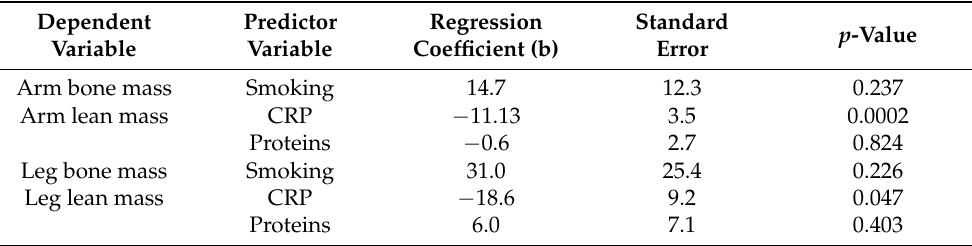
Table 3. Summary of regression analysis for variables predicting ERA-specific body struc- tural changes